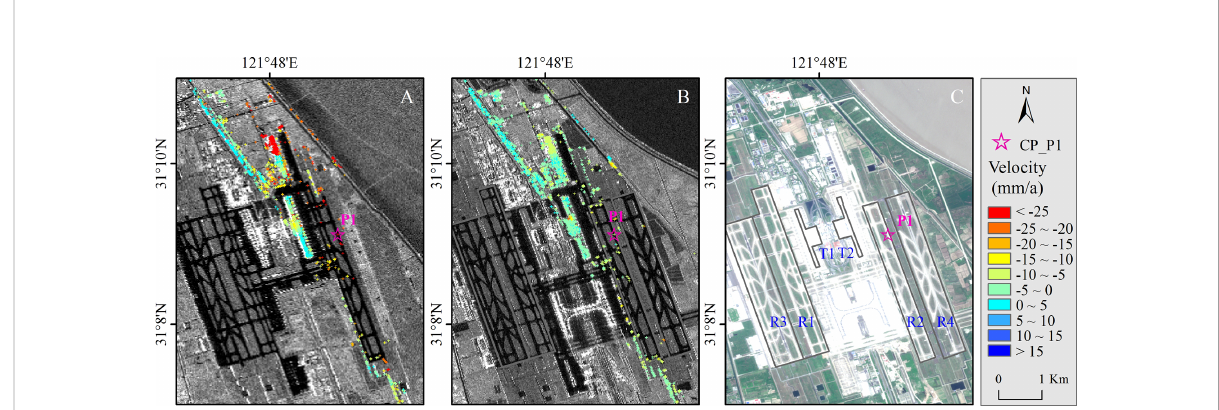
FIGURE 8 Subsidence comparison of typical site (CP_P1) in Pudong Airport Reclamation Project during the two periods of 2007-2010 (A) and 2017-2020 (B) . The background of (A, B) is a mean SAR intensity map of the two kinds of used dataset, respectively, and (C) is superimposed on the Sentinel-2A image.